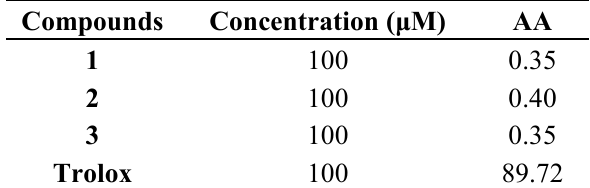
Table 4. Antioxidant capacities (AA) of oxoisoaporphines 1 – 3 evaluated from protection of 